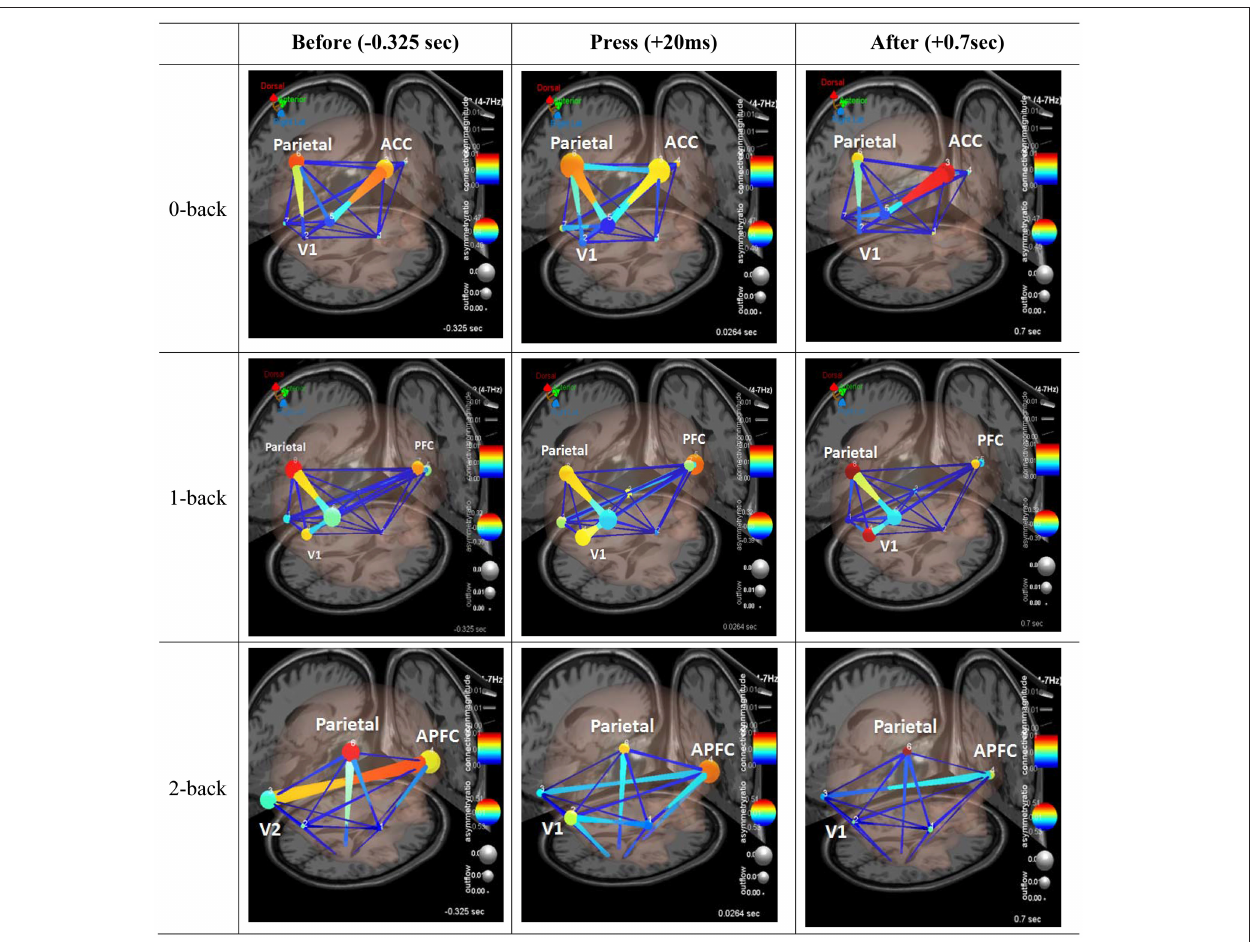
FIGURE 6 | Effective connectivity analysis. Three frames of a causal brain maps show transient theta information flow during correct commission: The frames correspond to − 325ms (left), 20ms (center), and 70ms (right) relative to the button press (0ms). The color of the edges represents connectivity strength (i.e., amount of information flow along that edge.). Red = high connectivity, Green = low connectivity. The size of edges of the graph represents connectivity magnitude (absolute value of connectivity strength). The color of node represents the asymmetry ratio of connectivity for that source. Red = causal source, blue = causal sink, green = balanced flow. The size of a node represents the amount of information outflow from the